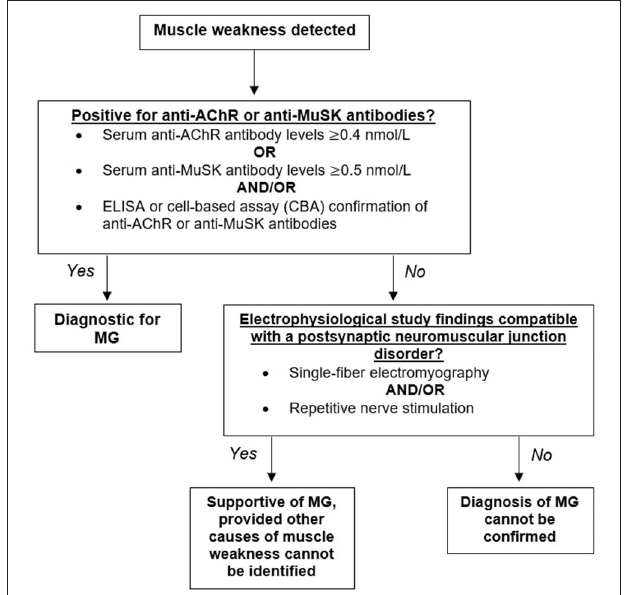
FIGURE 2 | Diagnostic algorithm for myasthenia gravis (MG). Having identified muscle weakness in a patient, biomarkers for myasthenia gravis should next be assessed. Detectible levels of antibodies against the acetylcholine receptor (AChR) or the muscle-specific kinase (MuSK) should be present for a firm diagnosis of MG. Seronegative patients demonstrating muscle weakness confirmed through repetitive nerve stimulation and/or single-fiber electromyography would yield a supportive